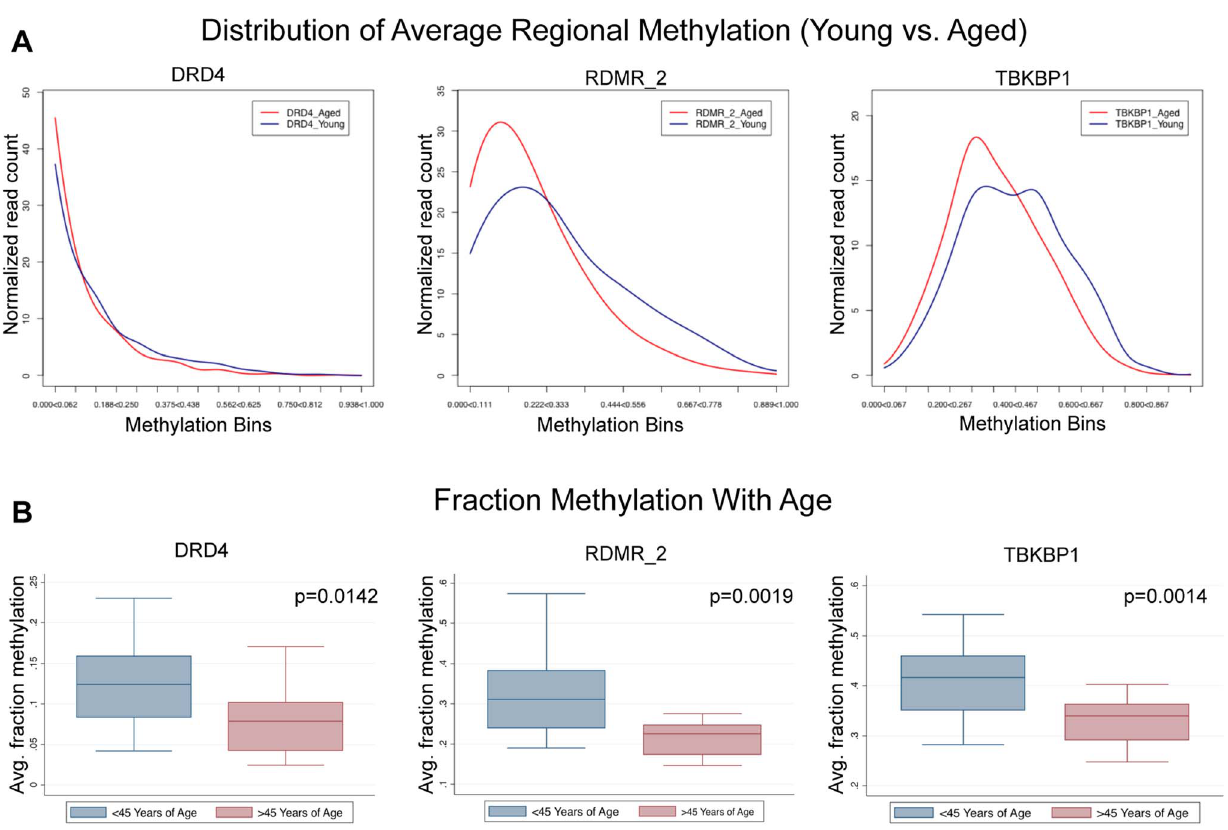
Figure 5. Single molecule analysis reveled 3 distinct alterations that occur with age. (A) DRD4 has only slight alterations associated with age because the young cohort ( , 45) is strongly hypomethylated initially, and aging simply amplifies this. RDMR_2 is representative of many alterations observed in this analysis which had a strong population shift from moderately hypomethylated to hypomethylated. TBKBP1 is representative of sites that had a bimodal distribution methylation patterns in the young group that becomes stabilized with age. (B) in every case (DRD4, RDMR_2, TBKBP1) each region has significant demethylation with age though the magnitude of change varies.